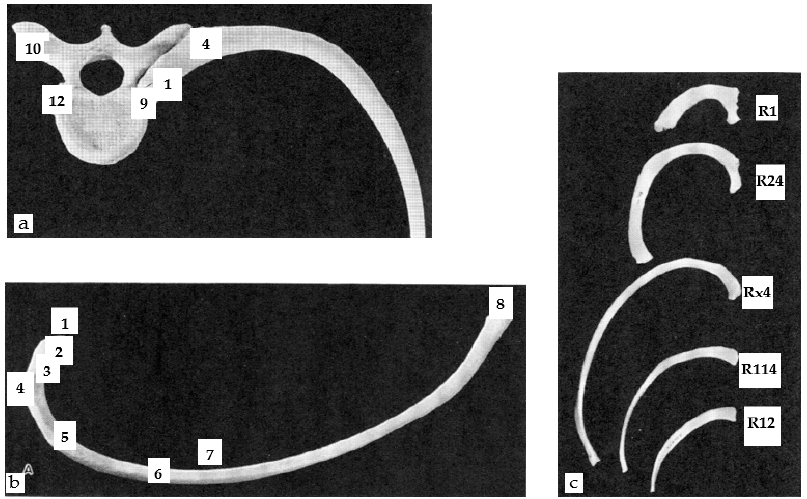
Figure 2 . The ( a ) articulation of vertebra and left rib, superior, ( b ) right central and superior view of the rib, and ( c ) comparative view of ribs.